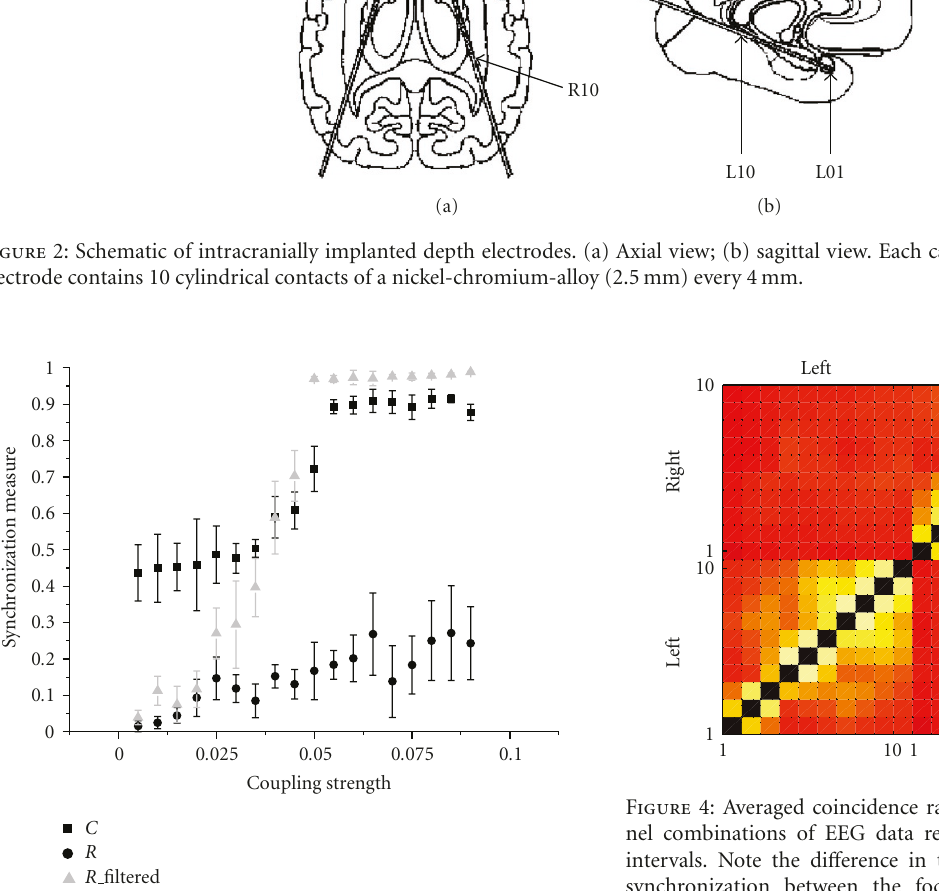
Figure 3: Means and standard deviations of the mean phase coher- ence R (circles and triangles) and the coincidence rate C (squares) estimated from the noisy (SNR = − 6dB) x -components of coupled R¨ossler systems for varying coupling strength κ . Triangles indicate values of R from low-pass filtered data. To calculate the coincidence rate C the internal frequency w int of FHN units in both media was chosen to match the natural frequencies of the R¨ossler oscillators = w B ≈ 1 by setting (cid:2) = 5). ( w A int int